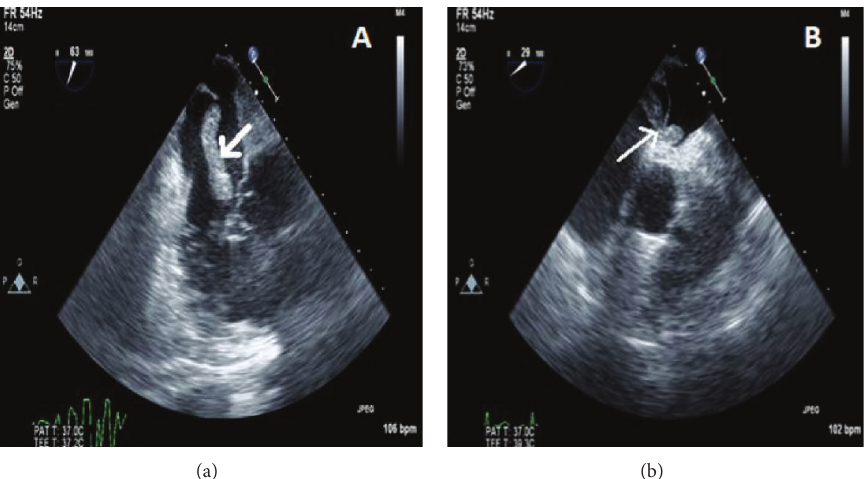
Figure 1: Transesophageal echocardiogram images showing a large snake-like thrombus in the RA (a) trapped in a PFO and extending into the left atrium